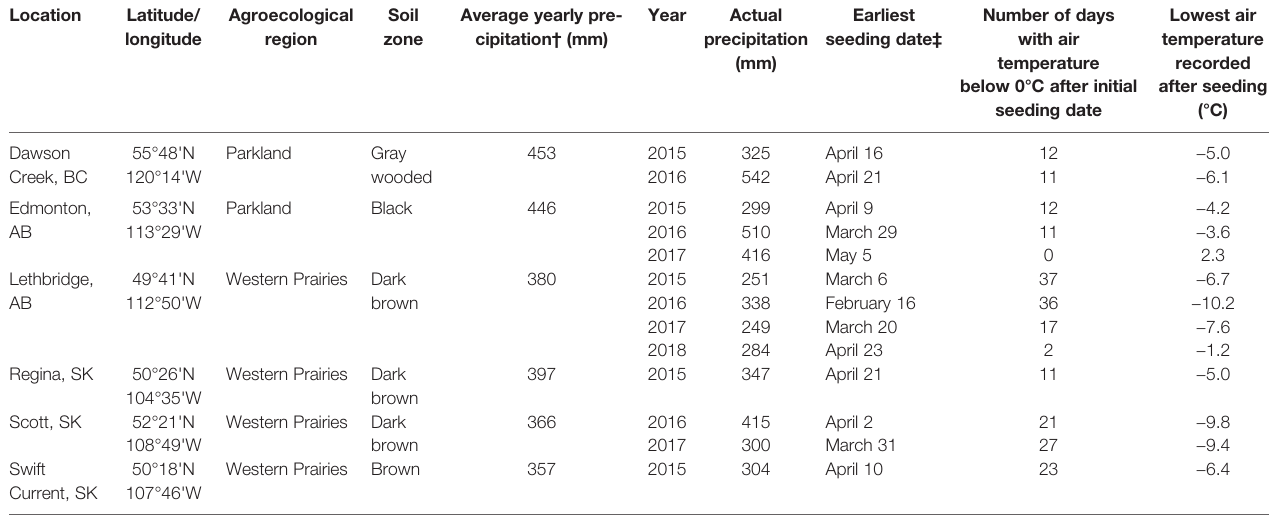
TABLE 1 | Average precipitation, post-seeding air temperature extremes and cumulative freezing events for each location x year. Location Latitude/